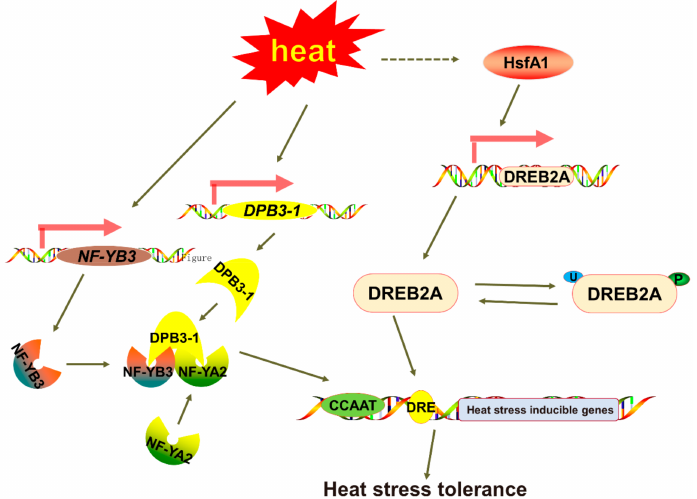
Figure 9. A model of the function of NF-YB3 under heat stress. The NF-YB3 , DREB2A and DPB3-1 genes are induced by heat stress. The NF-YB3, NF-YA2, and DPB3-1 form a trimer in the nucleus. Thereafter, the trimer enhances the efficiency of transcription by DREB2A. The NF-YB2 is suggested to activate the heat inducible genes through CCAAT elements and the DREB2A activates the target genes through DRE elements, which results in the heat stress